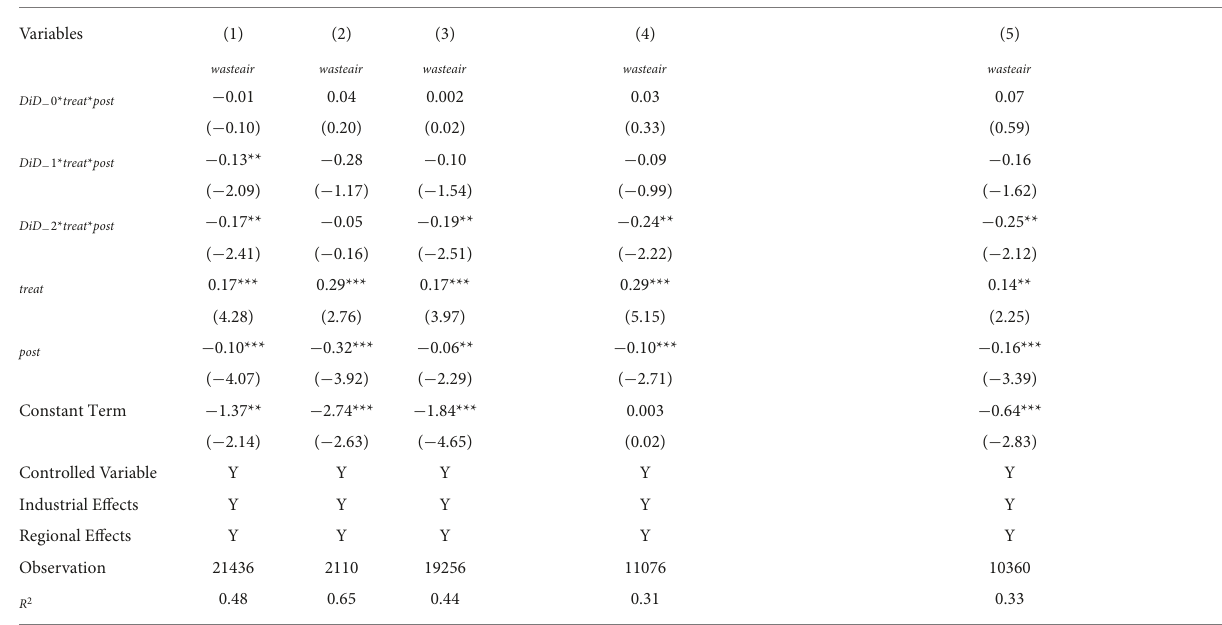
TABLE 6 Dynamic marginal effects of total industrial wasteair